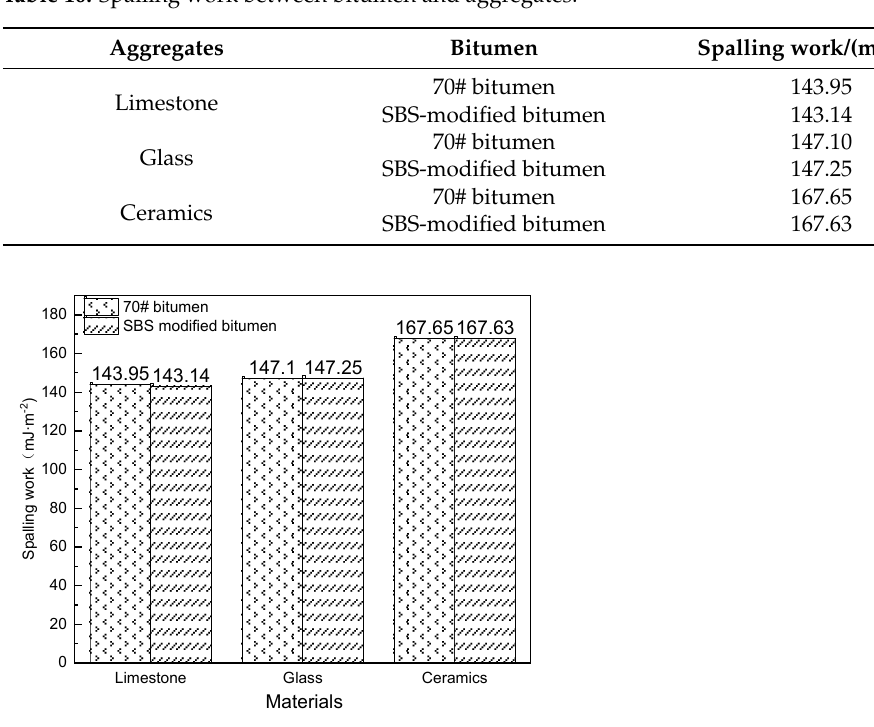
Figure 12. Spalling work between bitumen and aggregates.